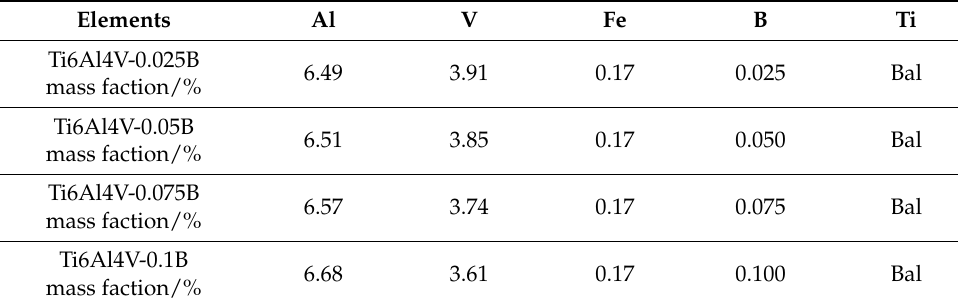
Table 1. Mass percentage of main elements in alloy powder.